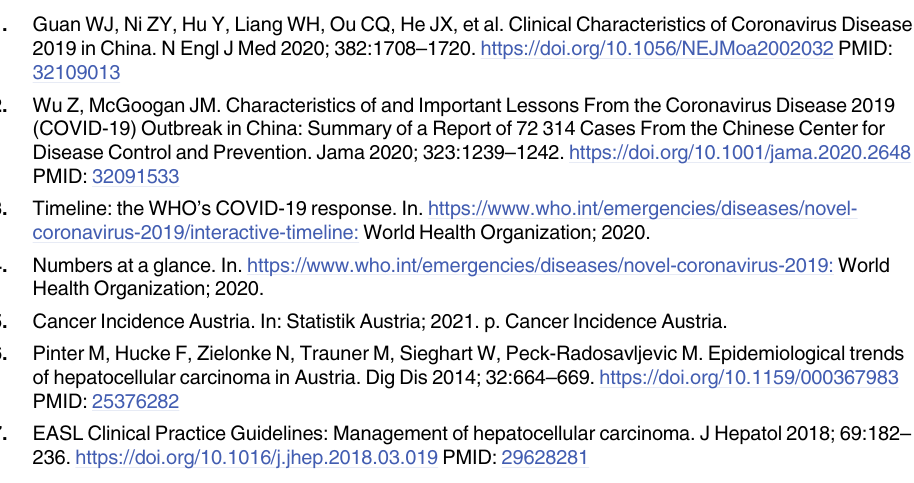
S1 Table. Baseline characteristics between period 1 and period 2 in patients with newly diagnosed hepatocellular